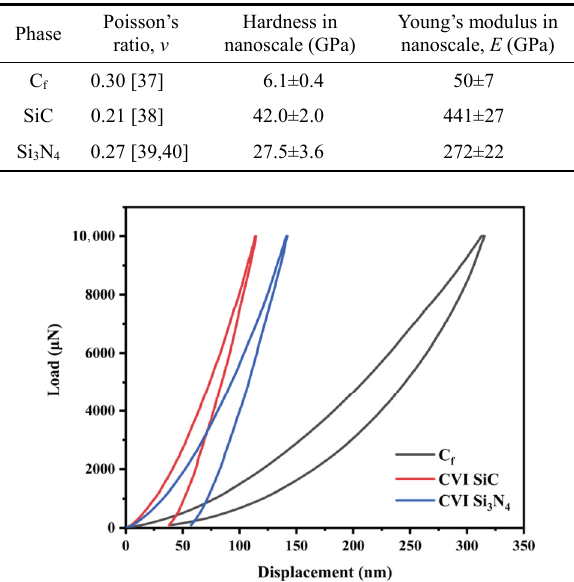
Fig. 7 Typical load–displacement curves of nanomechanical tests of carbon fiber (C f ), SiC matrix, and Si 3 N 4 matrix. the stiffness of samples S1 and S2 lower than that of sample S0, showing lower flexural modulus (Fig. S2 in the ESM).